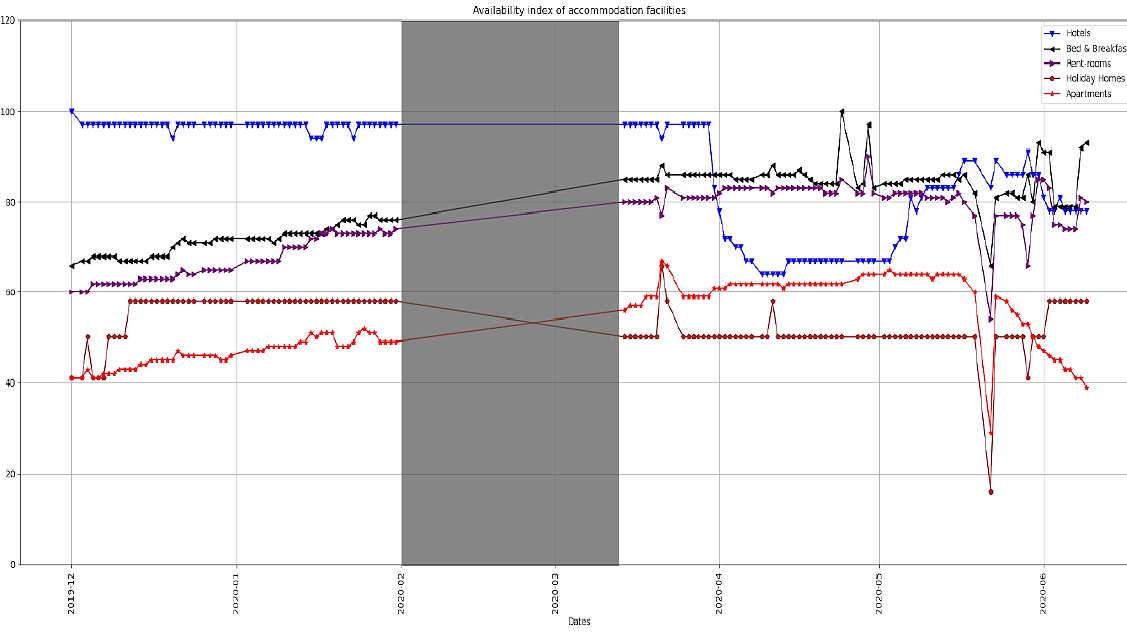
Figure 4. Availability index of accommodation facilities